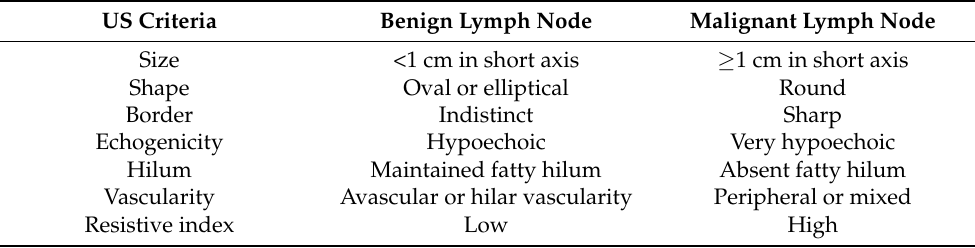
Table 1. US and Doppler features of benign and malignant lymph nodes. There is no sole criterion to define malignant lymph nodes. Constellation of multiple features suggest malignancy. Additionally, significant overlap between reactive and malignant lymphadenopathy